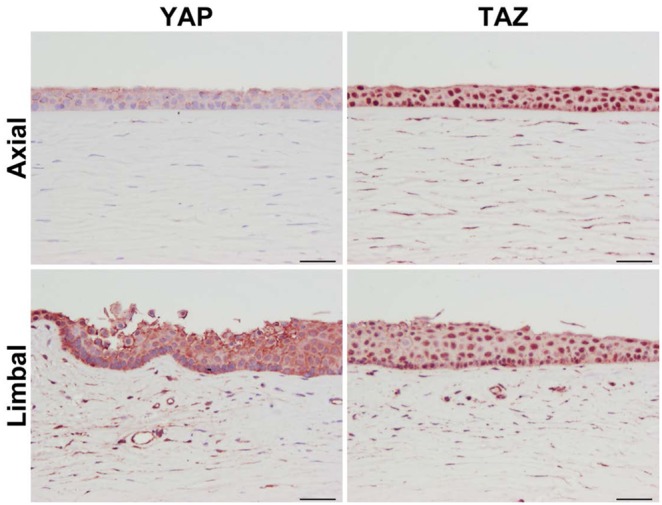
Representative image demonstrating differential expression of YAP and TAZ in human corneal epithelium.
(Left panels) Expression of YAP in both the axial and limbal corneal epithelial sections was cytoplasmic for this donor. Stromal cells stained weakly for YAP. (Right panels) Expression of TAZ on the other hand was predominantly nuclear both in the axial and limbal regions of the corneal epithelium. Scale bar represents 50 µm.